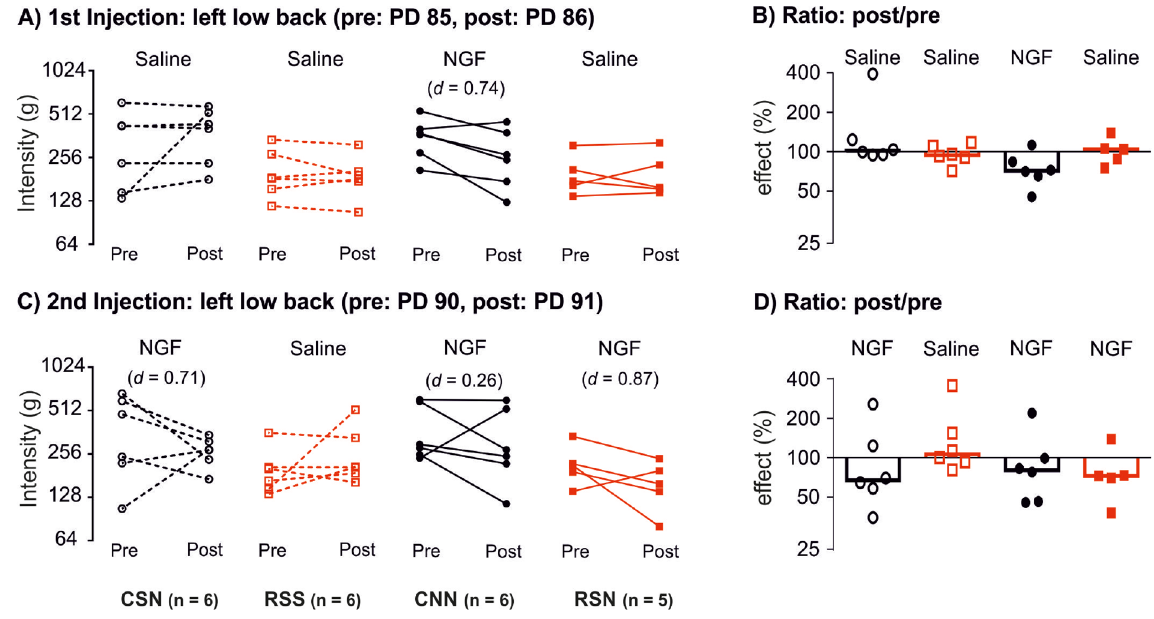
Figure 3. Pressure pain threshold before and after saline/NGF injections. Intramuscular NGF injection leads to an increased pain-related behavior when preceded by repeated restraint stress. ( A ) First injection, pair- wise comparison of individual data points pre and post injection expressed in log scale, force (in ‘g’ on the left y-axis) required to elicit a pain-related reaction (withdrawal behavior, escape movements, vocalization) using a blunt probe with an area of 3.46 mm 2 when applied to the left multifidus muscle of the low back. ( B ) Individual data points in ratio (in ‘%’), change of pressure of pain threshold shown as effect post/pre. Bars indicate the median for each group. ( C ) Second injection, pair-wise comparison of individual data points pre and post injection expressed in log scale, force (in ‘g’ on the left y-axis). ( D ) Individual data points in ratio (in ‘%’), change of pressure pain threshold shown as effect post/pre and bars indicate the median for each group. Effect size is shown as Cohen d . NGF, nerve growth factor. CSN: control + saline + NGF; RSS: repeated restraint stress + saline + saline; CNN: control + NGF + NGF; and RSN: repeated restraint stress + saline + NGF. PD: postnatal day. Black circles: control animals, red squares: stressed